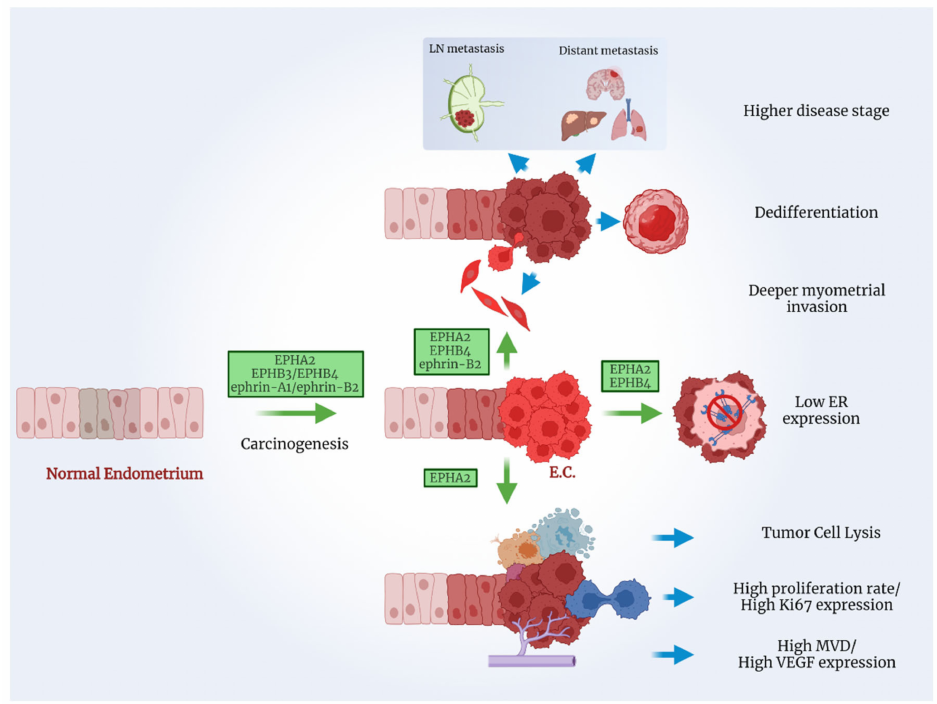
Figure 3. Members of the EPH/ephrin system promote various steps of EC tumorigenesis. Created with BioRender.com. Table 4. The role of the EPH/ephrin system in EC cell lines and human xenografts. EPHs/Ephrins Cell Lines Methods Main Results